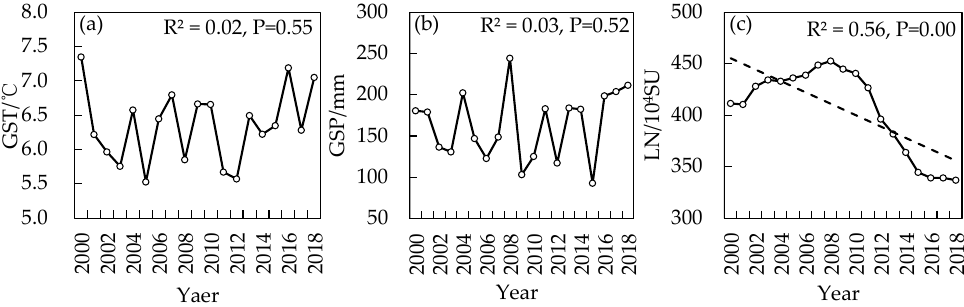
Figure 3. Interannual variations in ( a ) GST, ( b ) GSP, and ( c ) LN.